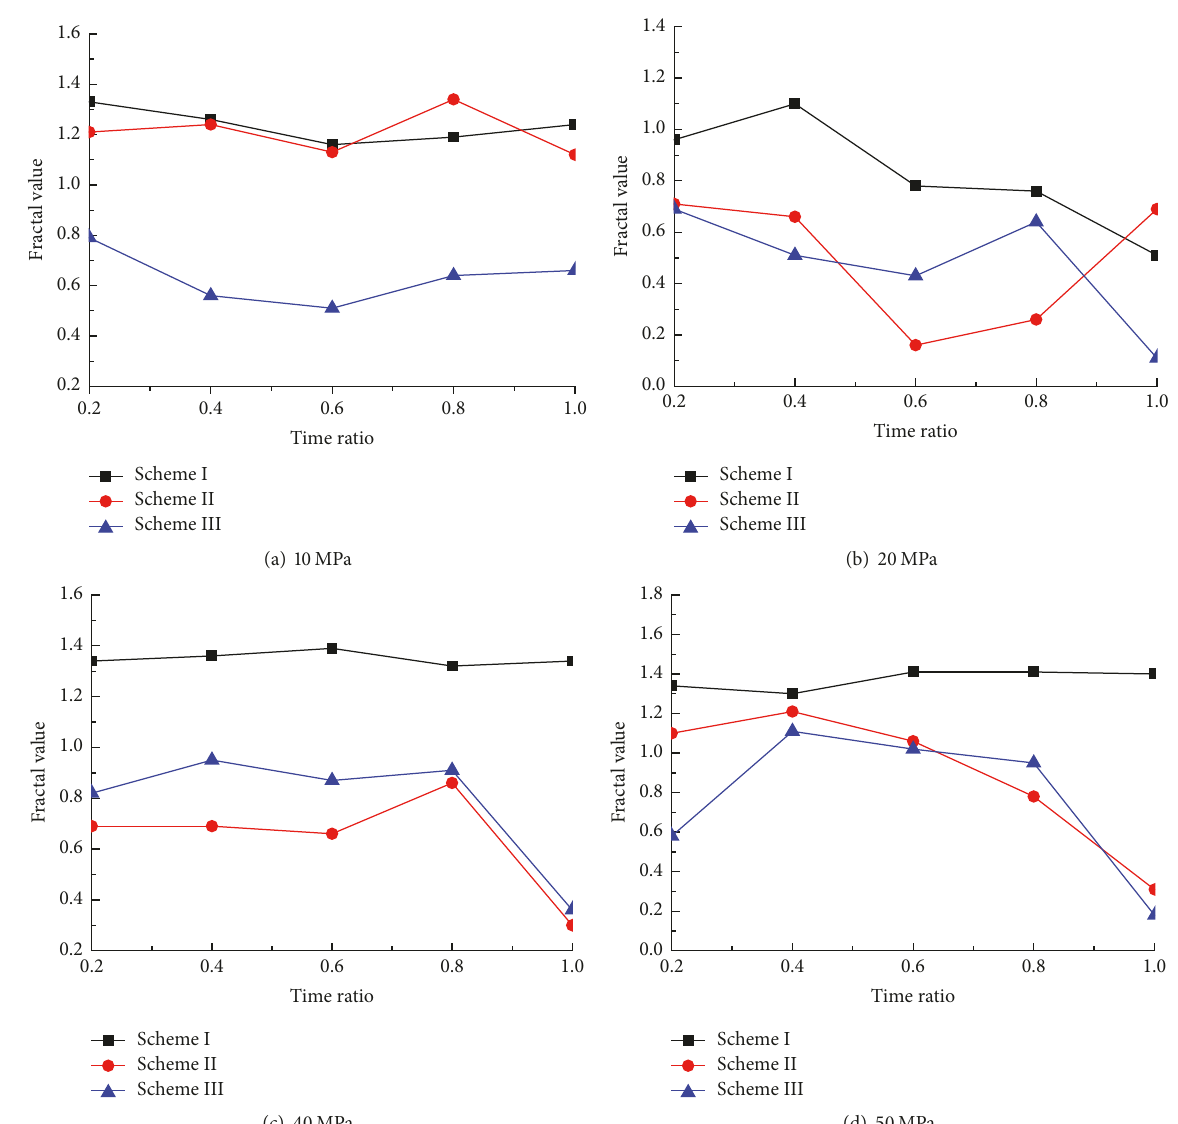
Figure 7: Fractal values of AE of sandstone samples under different stress paths (time